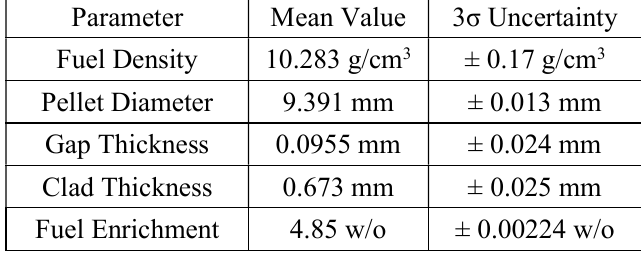
Table I. Material parameters: Mean value and uncertainty associated with five material